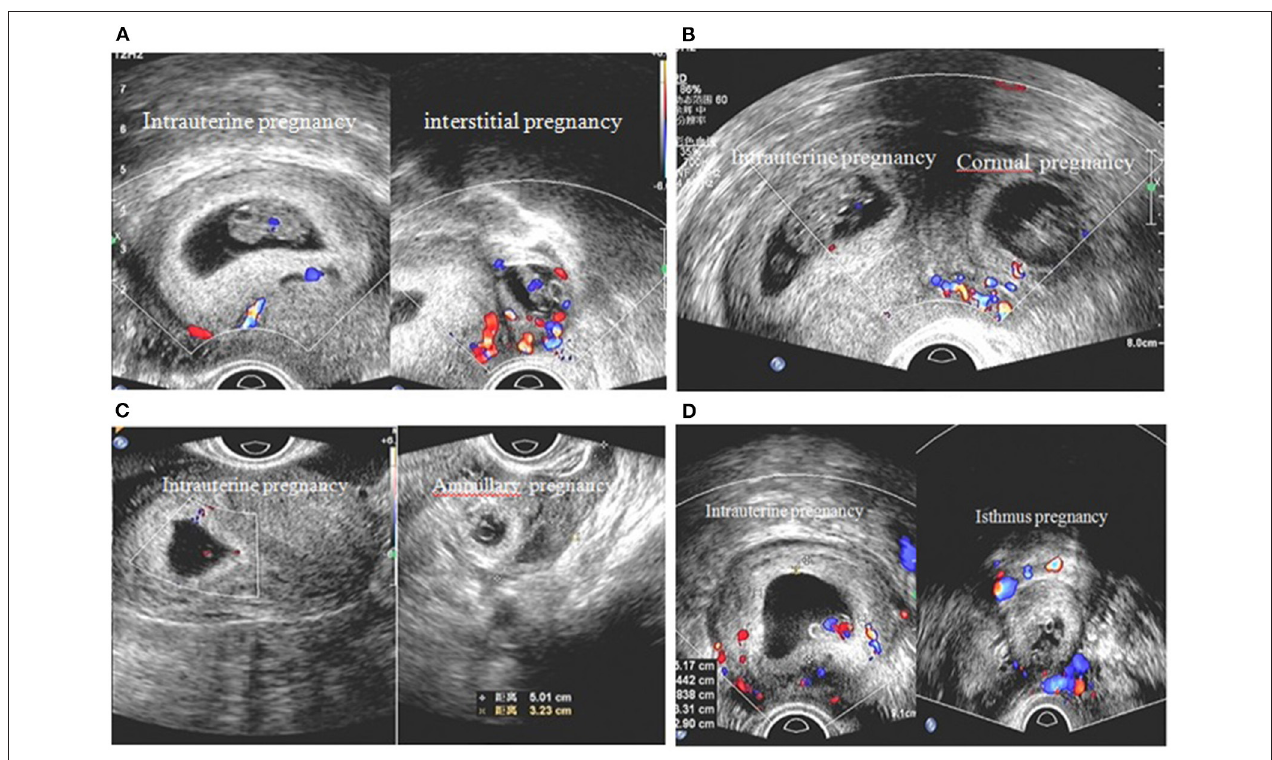
FIGURE 1 | Ultrasound diagnosis of intrauterine pregnancy and location of ectopic pregnancy. Heterotopic pregnancy with different locations: (A) intrauterine pregnancy and left interstitial pregnancy (B) intrauterine pregnancy and right cornual pregnancy (C) intrauterine pregnancy and left fallopian ampullary pregnancy (D) intrauterine pregnancy and left fallopian isthmus